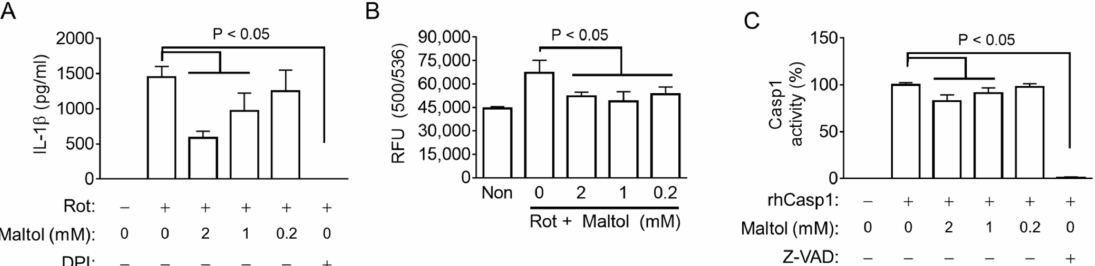
Figure 4. Effect of maltol on the ROS production and Casp1 activity. ( A ), LPS-primed BMDMs were treated with rotenone (Rot) in the presence of maltol or DPI (a ROS scavenger). IL-1 β secretion was analyzed by ELISA. ( B ), LPS-primed BMDMs were treated with DHR123 to measure ROS production in the presence of Rot with/without Maltol. Relative fluorescence unit (RFU) as the level of ROS was measured. ( C ), Recombinant human (rh) Casp1 was incubated with maltol or Z-VAD-FMK (Z-VAD, a pan-caspase inhibitor), and the Casp1 activity was analyzed using an assay kit. The bar graph presents the mean ±